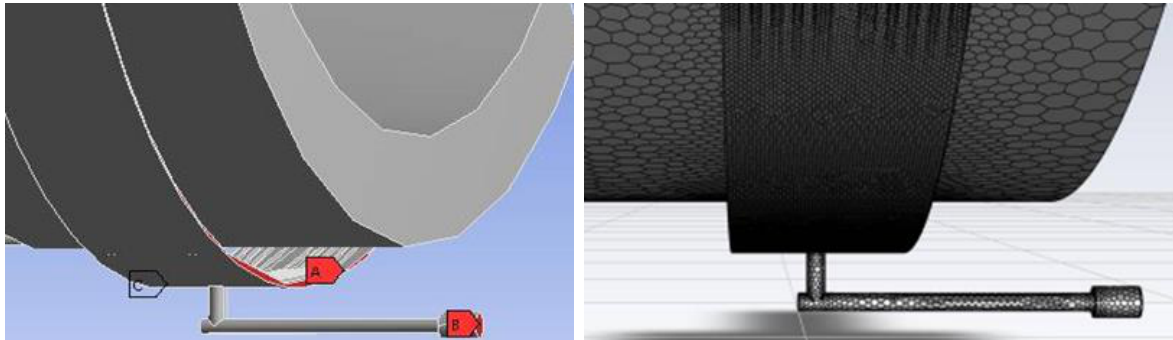
Figure 7. Boundary naming and